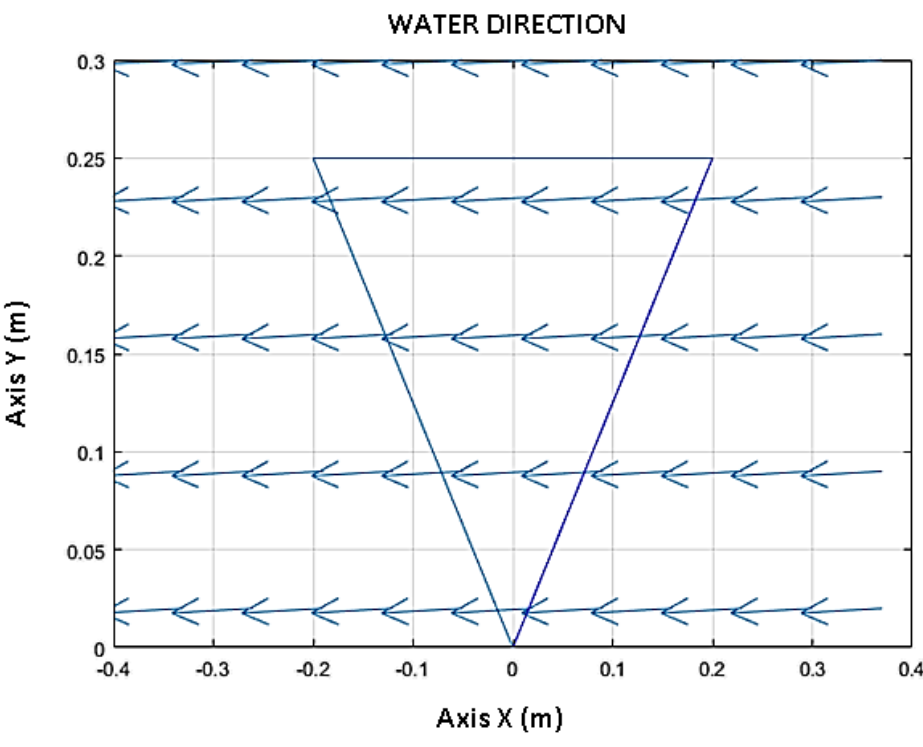
Figure 8. The results of the direction of the water calculated by the algorithm. This vector matches the water velocity vector. The triangle represents the parallel mechanism.